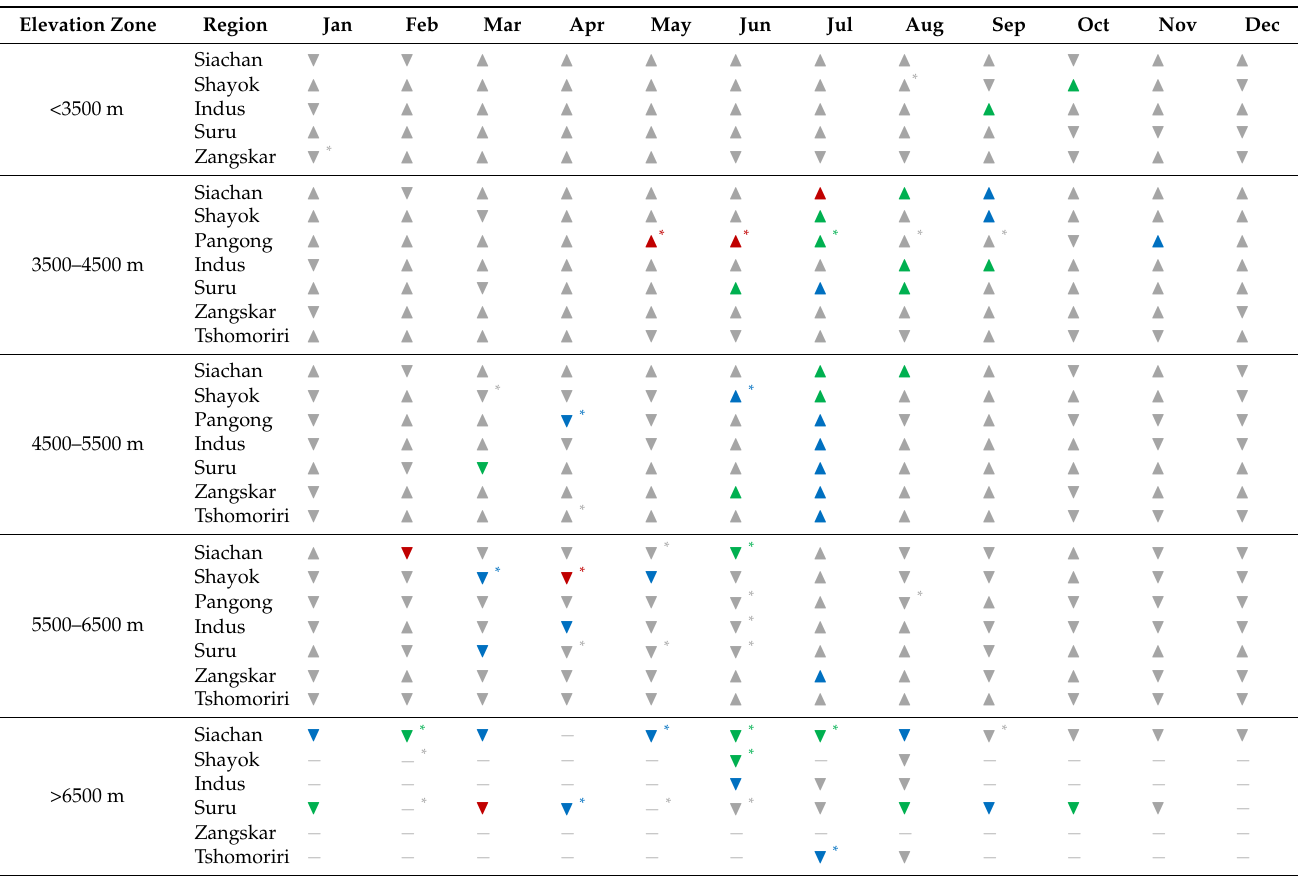
Table A3. Trend analysis of SCA in relation to the elevation zone (%) of all